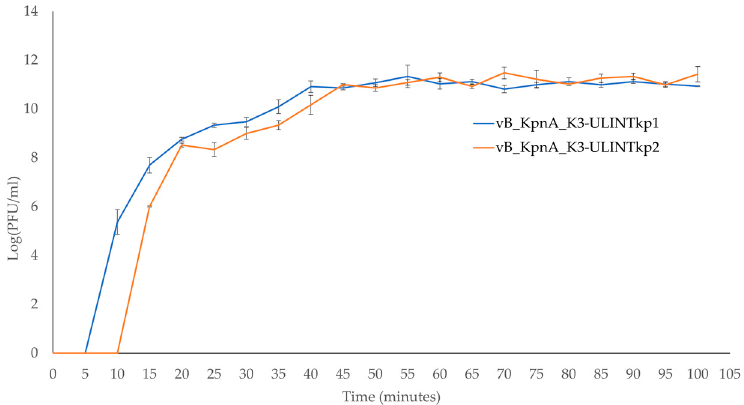
Figure 6. Low MOI bacteriophage kinetic curves of the bacteriophages vB_KpnP_K3-ULINTkp1 (blue curve) and vB_KpnP_K3-ULINTkp2 (orange curve).